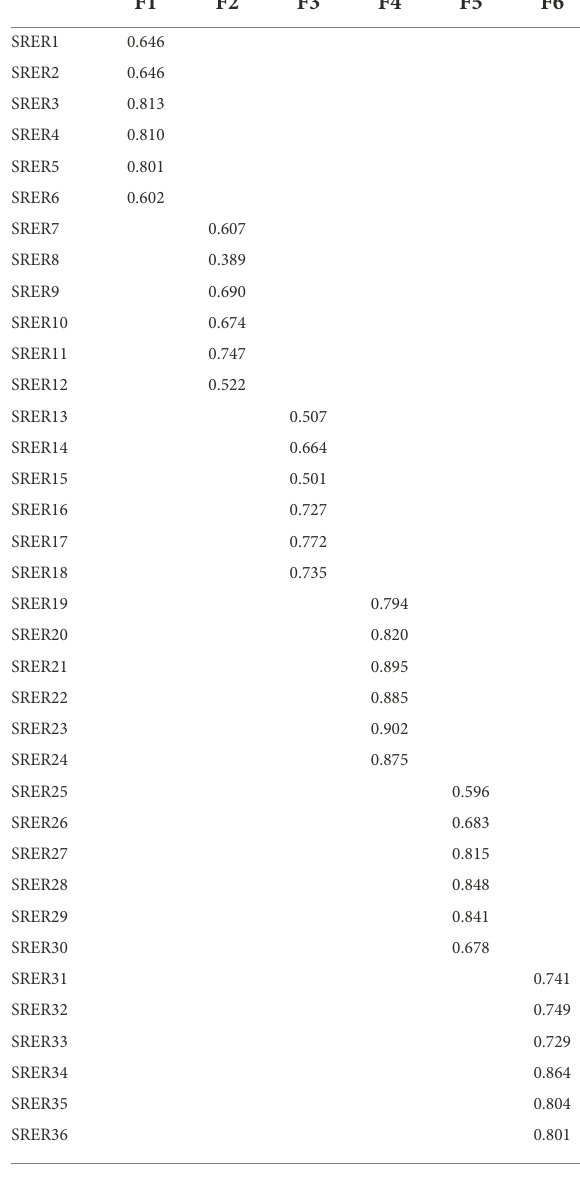
TABLE 11 Standardized total effects (default model; n =